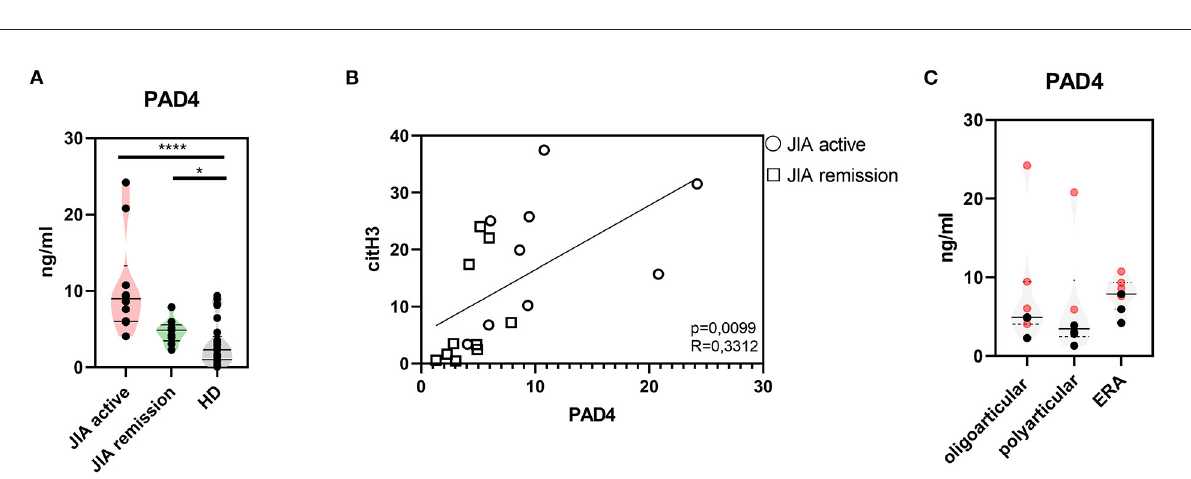
FIGURE3 Peptidyl arginine deiminase 4. (A) Peptidyl arginine deiminase 4 (PAD4) concentrations in JIA active ( n = 10), JIA remission ( n = 10), and healthy donors (HD = 16) detected using ELISA. (B) Correlations between the PAD4 and citH3 levels in JIA active and JIA remission groups. (C) PAD4 levels in JIA subtypes: oligoarticular/oligo-extended, polyarticular, and ERA groups. Patients with active JIA are displayed in red and patients with JIA remission are shown in black. Values are standardized and expressed as median values. Statistical analyses were performed using